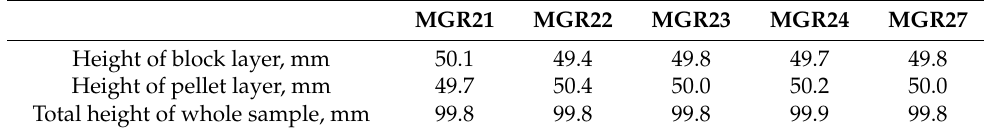
Table 1. The initial heights of sample layers in MGR experiments [43,44] and the model.